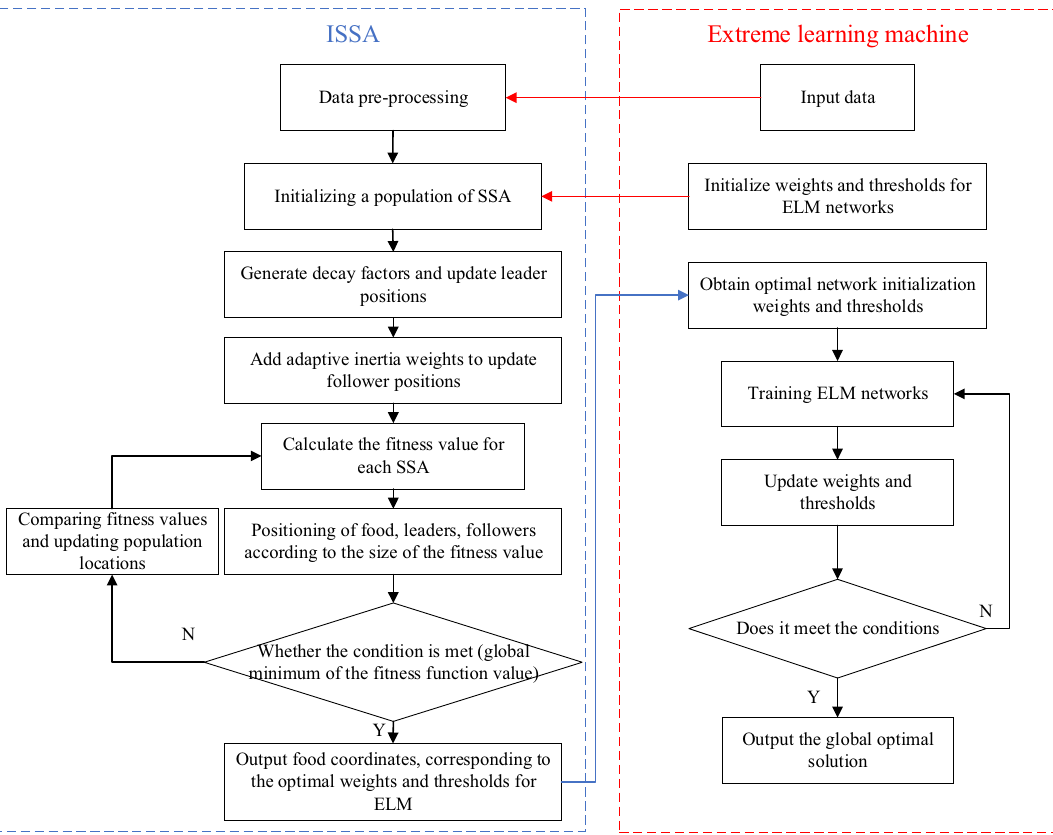
Figure 6. Flowchart of the optimized ELM based on the